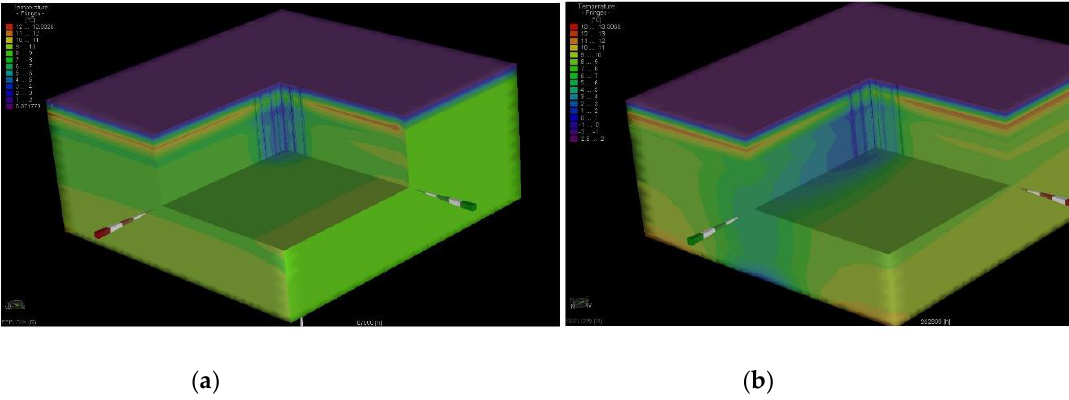
Figure 6. Results of 3D simulation of ground temperature after 10 years ( a ) and 30 years ( b ) of heat pump operation within the 1st scenario (homogeneous model); the view from the north-west.